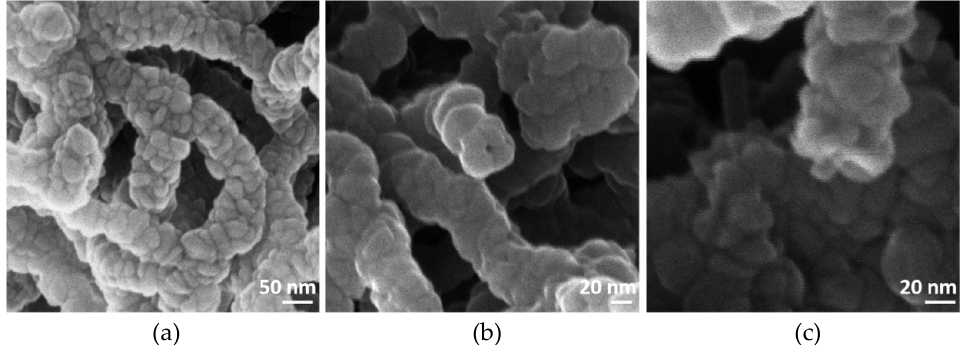
Figure 2. ( a ) HIM observation of CNT-ZnO structures; ( b , c ) higher magnification images after a cut using gallium ion beam. The micrographs feature a polycrystalline 18 nm-thick ZnO shell around CNT cores with a diameter of 12